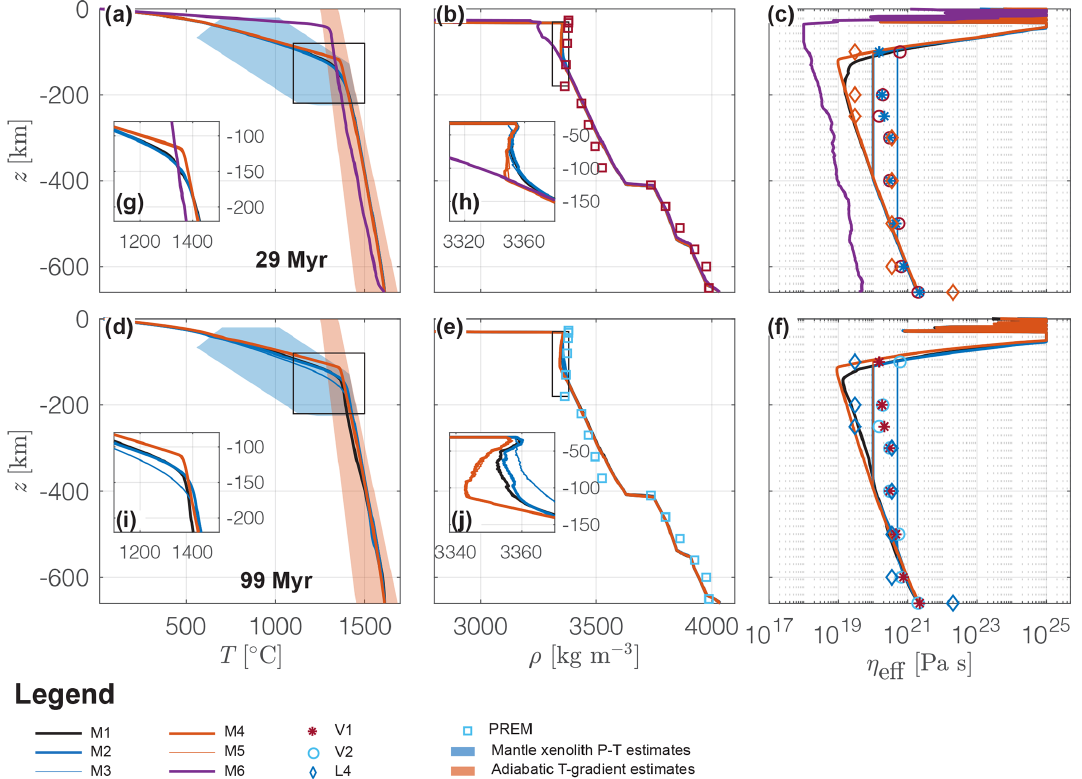
Figure 2. Horizontally averaged vertical profiles of temperature, T , density, ρ , and effective viscosity, η eff . (a–c) After 29Myr and (d–f) after 99Myr in model history. (a, d) Horizontally averaged temperature, (b, e) horizontally averaged density and (c, f) horizontally averaged viscosity. (g–j) An enlargement of the parental subfigure. Coloured lines show the results of models M1–6 as indicated in the legend. In (a, d) the blue area indicates P − T condition estimates from mantle xenolith data, and the orange area indicates estimates for a range of adiabatic gradients, both taken from Hasterok and Chapman (2011) (Fig. 5). Estimates for adiabatic temperature gradients are extrapolated to 660km of depth. In (b, e) squares indicate density estimates from the preliminary reference Earth model (PREM) (Dziewonski and Anderson, 1981). In (c, f) circles and stars indicate viscosity profiles inferred from Occam-style inversion of glacial isostatic adjustment and convection-related data originally by Mitrovica and Forte (2004); diamonds show a four-layer model fit of mantle flow to seismic anisotropy originally by Behn et al. (2004). All profiles are taken from Forte et al. (2010) (Fig. 2). The median is used as a statistical quantity for averaging because it is less sensitive to extreme values compared to the arithmetic